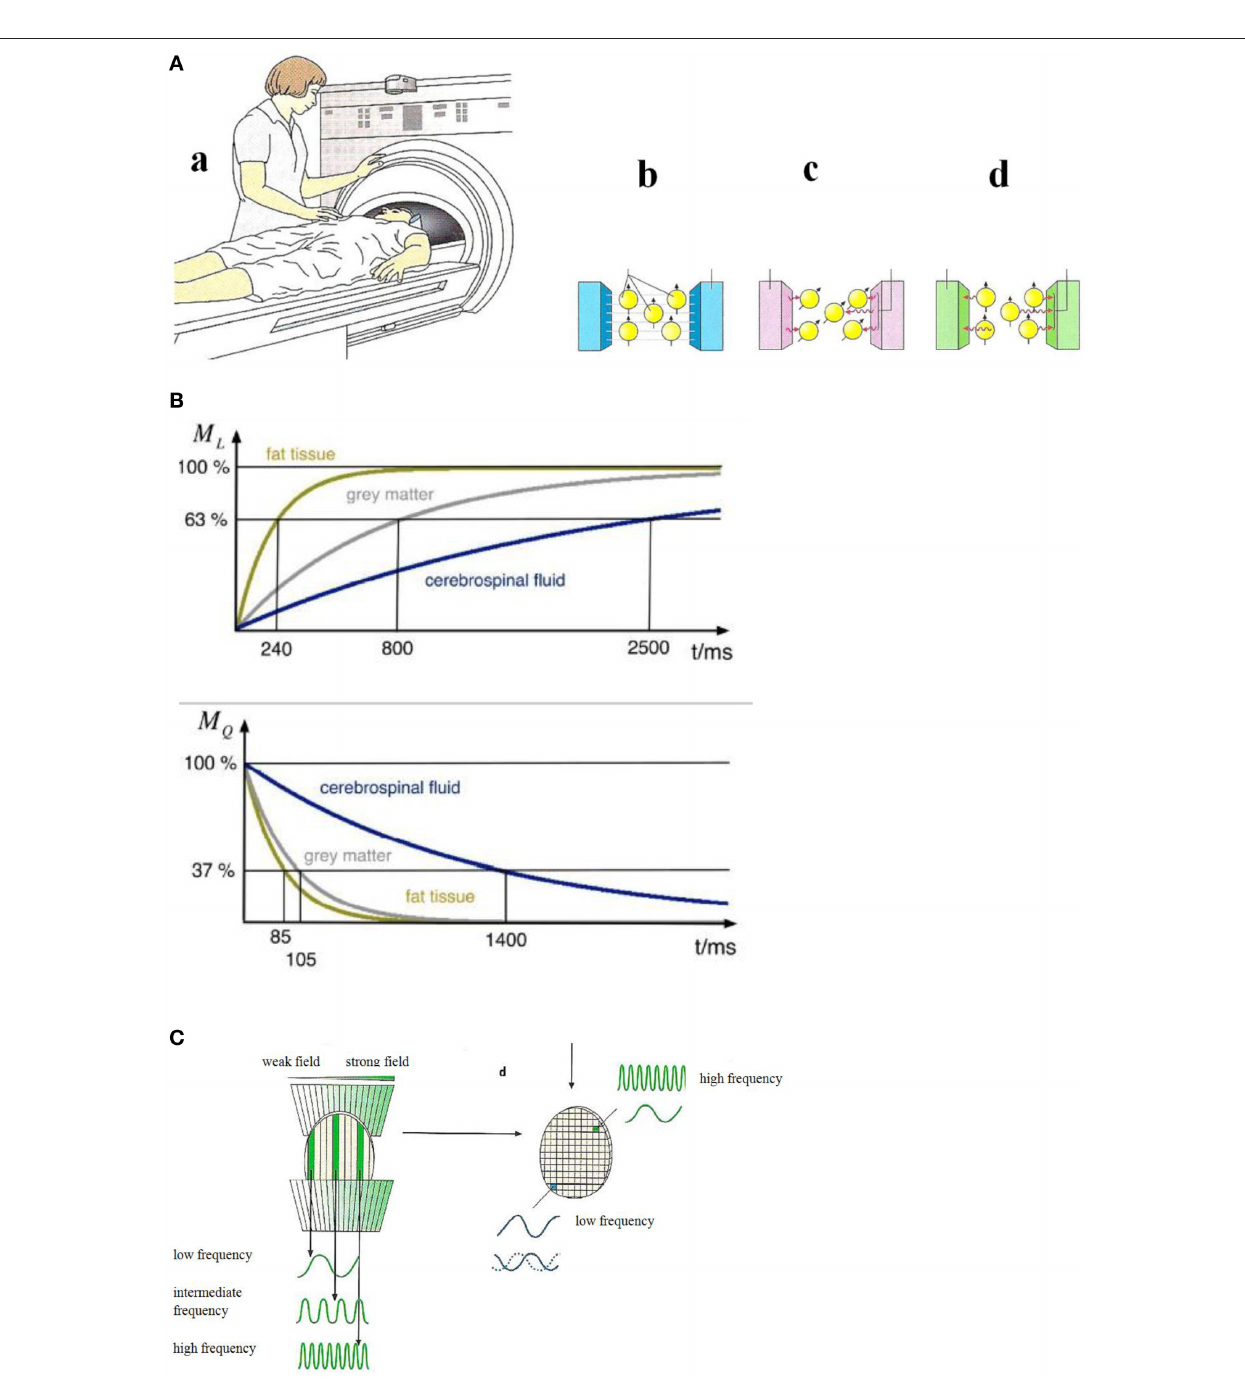
Frontiers in Neuroscience |